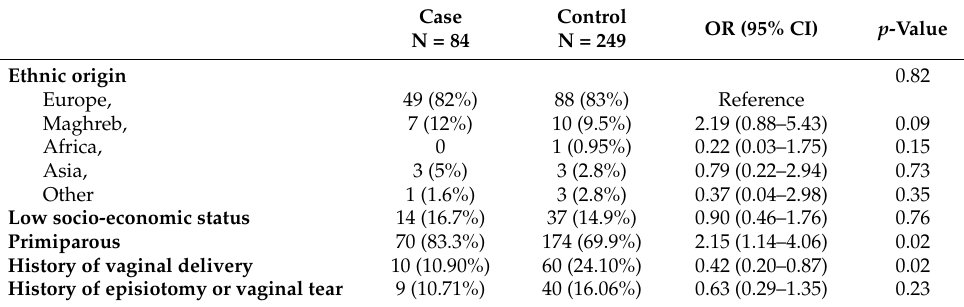
Table 1. Patient characteristics.